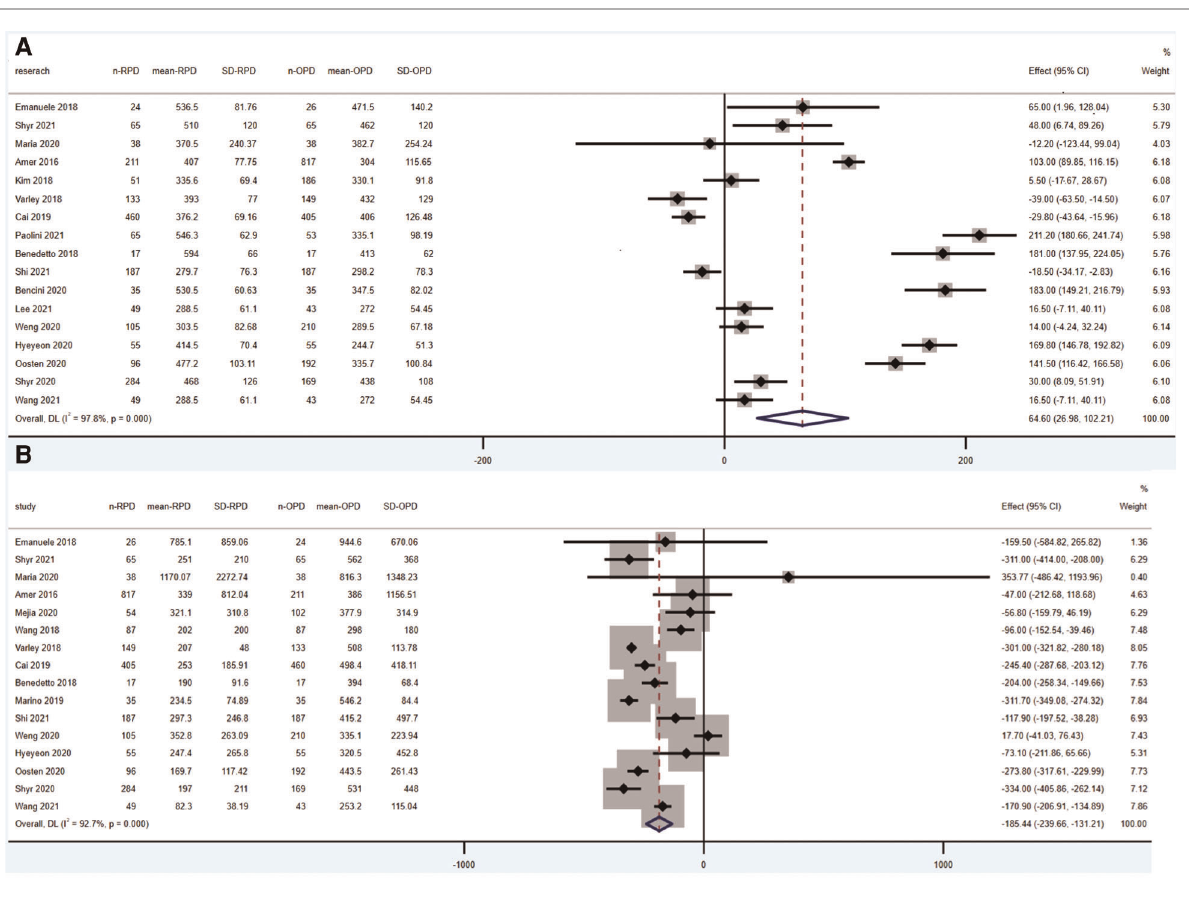
FIGURE 2 Meta-analysis of intraoperative outcomes: ( A ) operative time. ( B ) Estimated blood